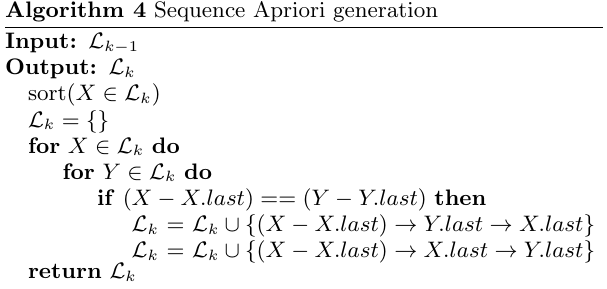
algorithm (algorithm 2) presented previously, the difference